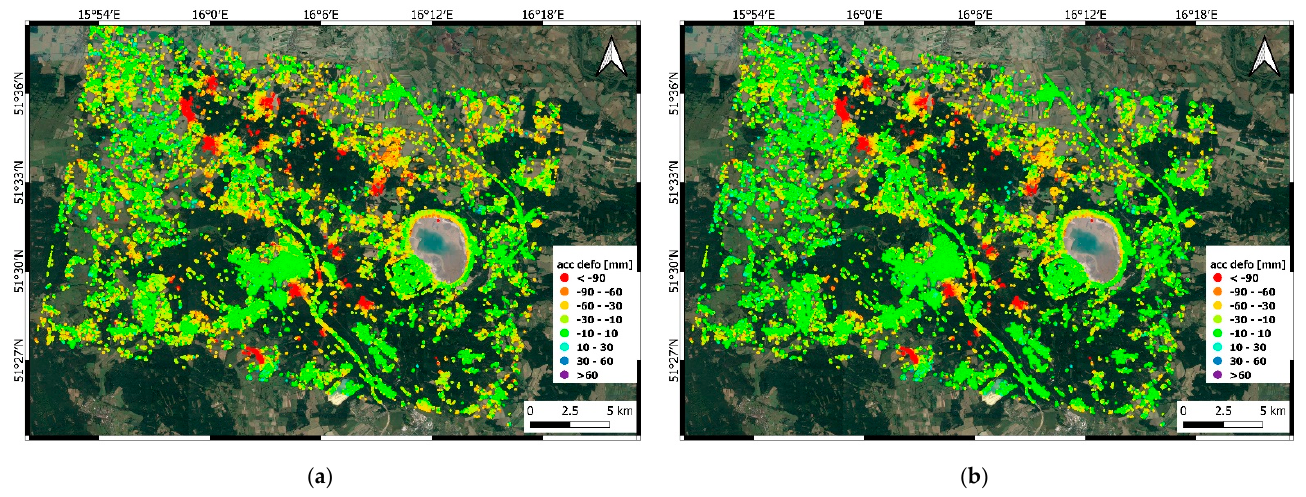
Figure 6. Accumulated deformation maps of the Sentinel-1 descending data, input ( a ) and output ( b ) from the APS filter.